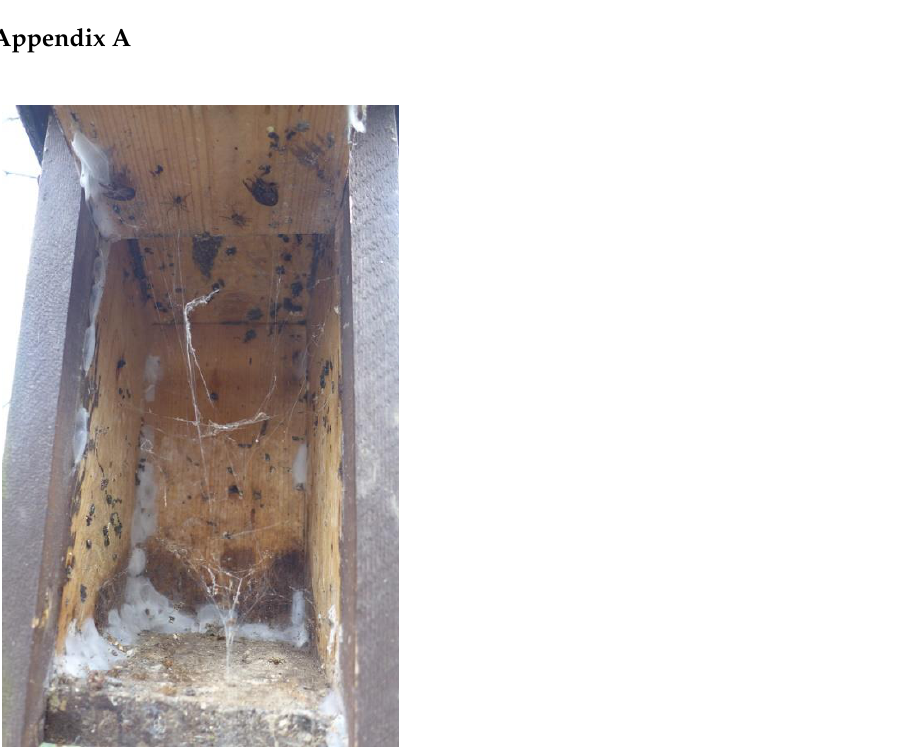
Figure A1. Open nesting box with overwintering spiders (silk sacs at the bottom — Clubiona pallidula ; web remains— Steatoda bipunctata ; Anyphaena accentuata and Nuctenea umbratica on the top ).